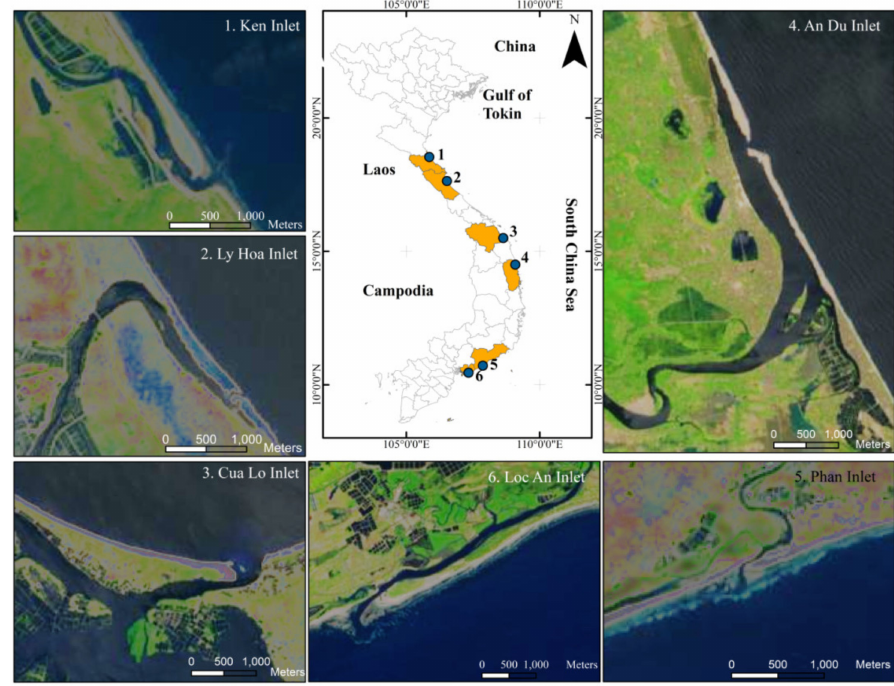
Figure 13. Location and morphology of six tidal inlets along the center coast of